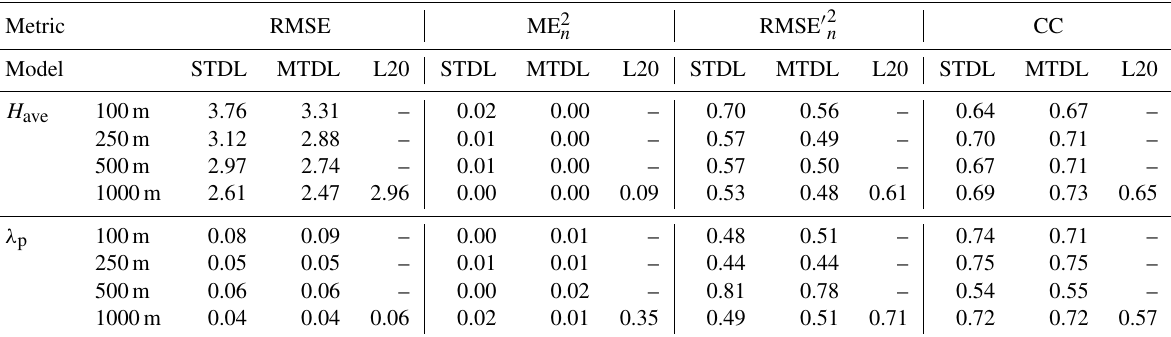
Table 4. Building height and footprint prediction evaluated in Glasgow. Error metrics including RMSE, ME 2 n and CC are calculated using pixels from the intersection part of masked reference and predictions.